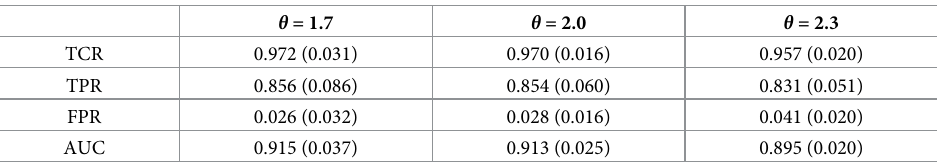
Table 3. Mean (sd) of predictive results for the no covariate example. θ = 1.7